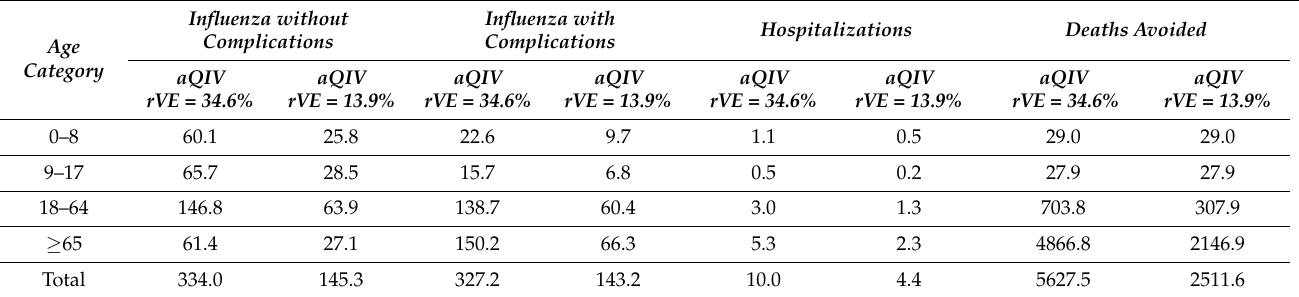
Table A3. Total (population) incremental quality-adjusted life years.